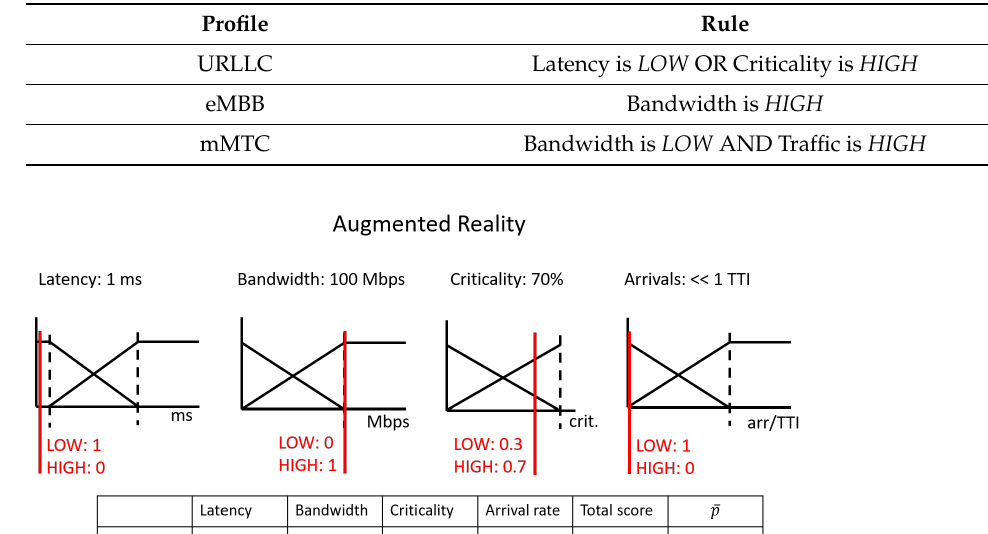
Figure 7. Membership functions for the LOW and HIGH fuzzy values. Table 1. Fuzzy rules.